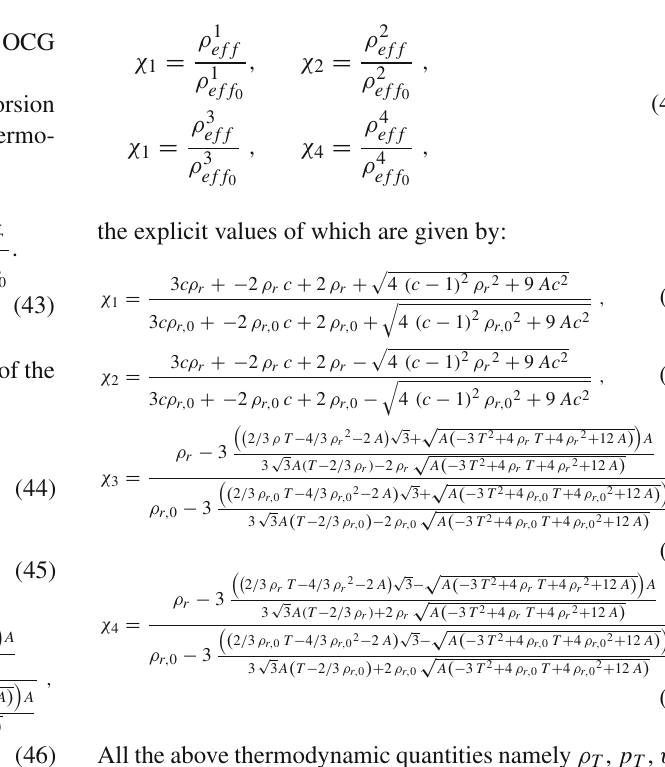
Fig. 1 Both panels show the plots of w ef f ( 1 , 2 , 3 , 4 ) versus a in the case of a radiation-torsion system for OCG at c = 2 . 5 and A = 1